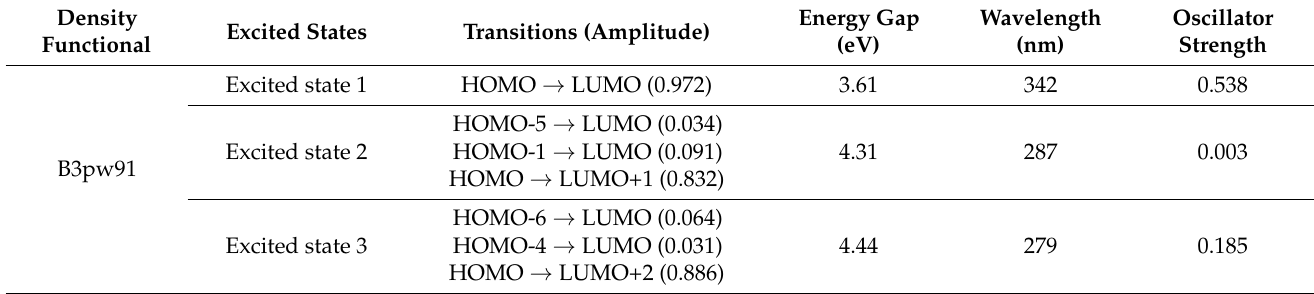
Table 1. Parameters of the first three of calculated excited